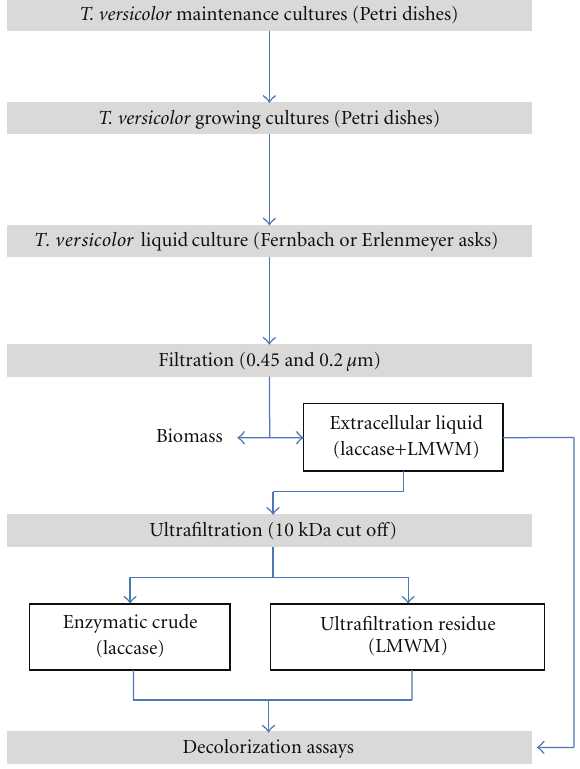
Figure 1: Experimental flow chart of the production of the enzy- matic fractions for accomplishment of decolorization assays: extra- cellular liquid (EL), enzymatic crude (EC), and ultrafiltration resi- due